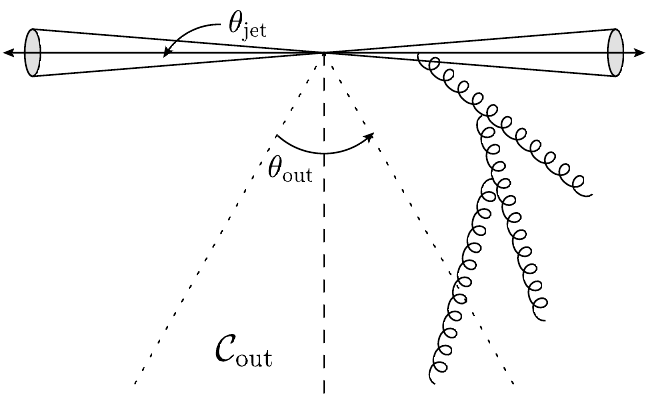
Figure 1 . A typical set-up for the emergence of non-global logarithms, as resummed by the BMS